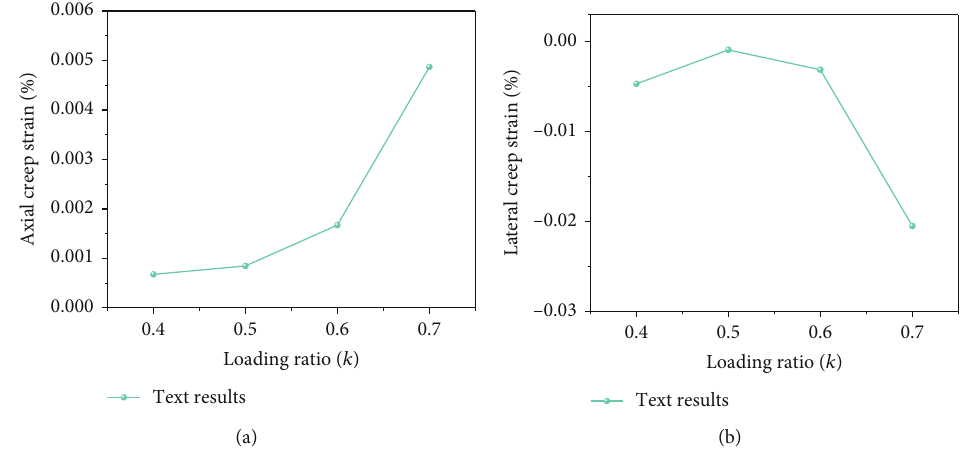
Figure 9: Relationship between the stress level and the creep